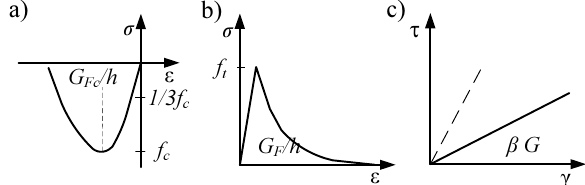
Fig. 9. Material models applied for concrete: a)